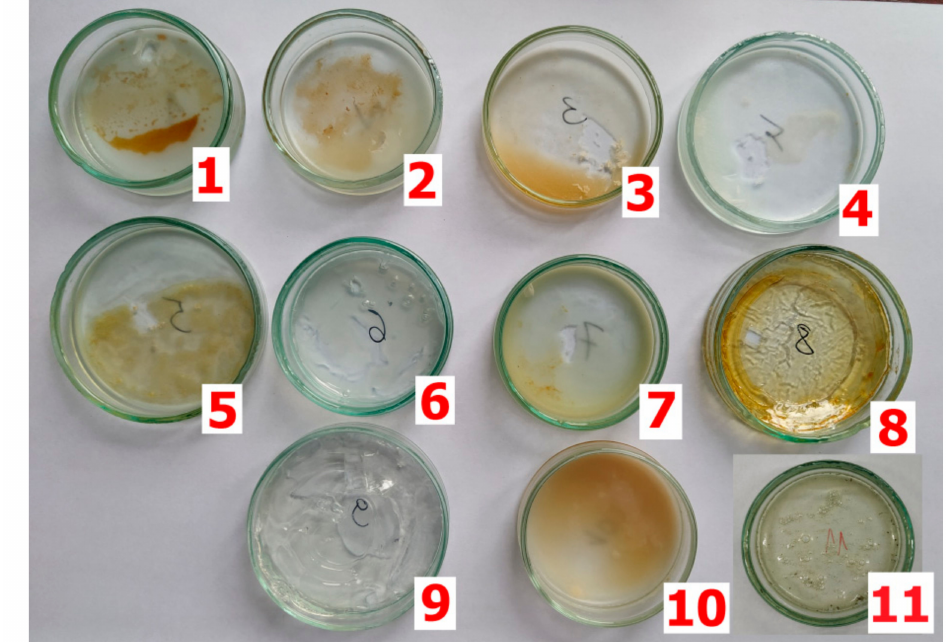
Figure 1. Samples of curing compound after drying (No.